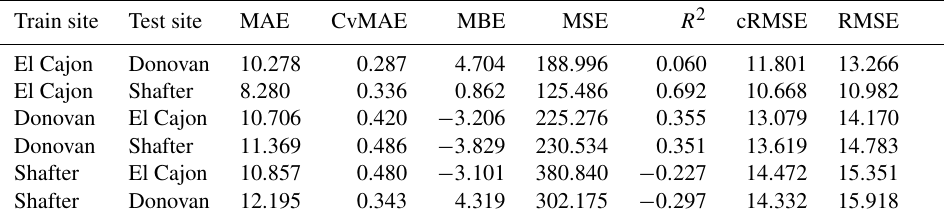
Table D3. Test results for split-NN Level 1, size 3 (O 3